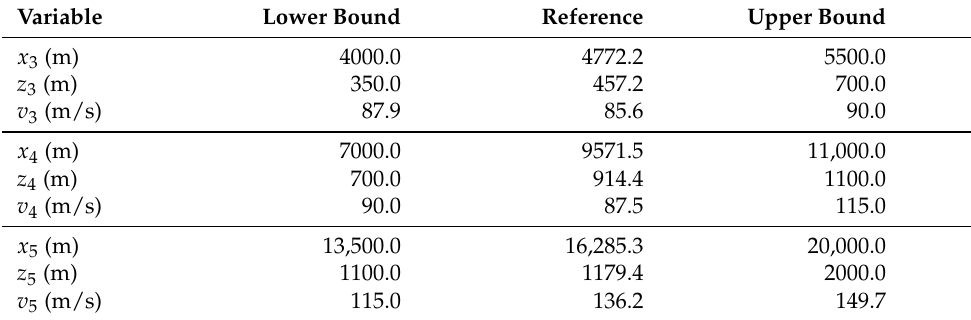
Table 6. Takeoff manoeuvre optimisation variables for the twin-aisle aircraft: reference values with upper and lower bounds.